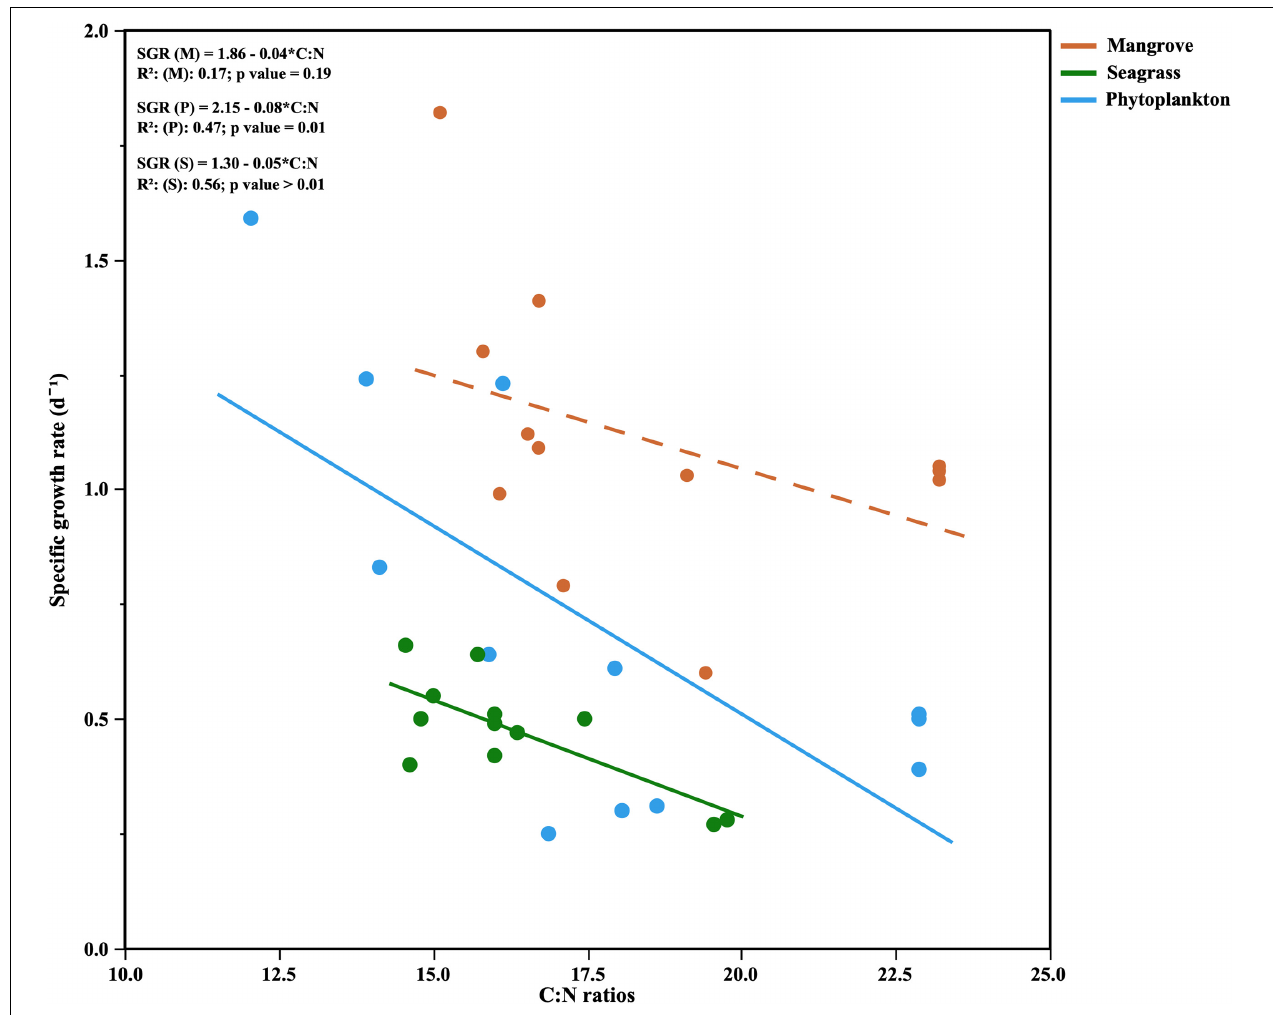
FIGURE 6 | Relationships between the specific growth rates of heterotrophic bacteria and DOM C:N ratios for each site. The OLS linear regression equations and coefficients of determination ( R 2 ) are shown as inserts in the figure. Dashed line represents non significant OLS linear regression. TABLE 2 | Mean ( ± SE) bacterial biomass increase ( (cid:49) BB/ (cid:49) t), DOC consumption rate ( (cid:49) DOC/ (cid:49) t), and bacterial growth efficiency (BGE) in the Filtered treatment incubations of samples from each month and site. Seagrass Mangrove